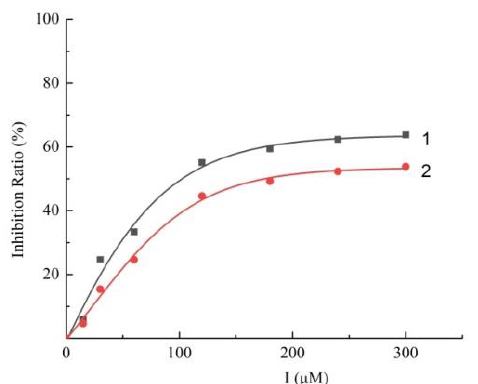
Figure 1. Inhibitory effect of Q1 (curve 1) and arbutin (curve 2) on mushroom tyrosinase.